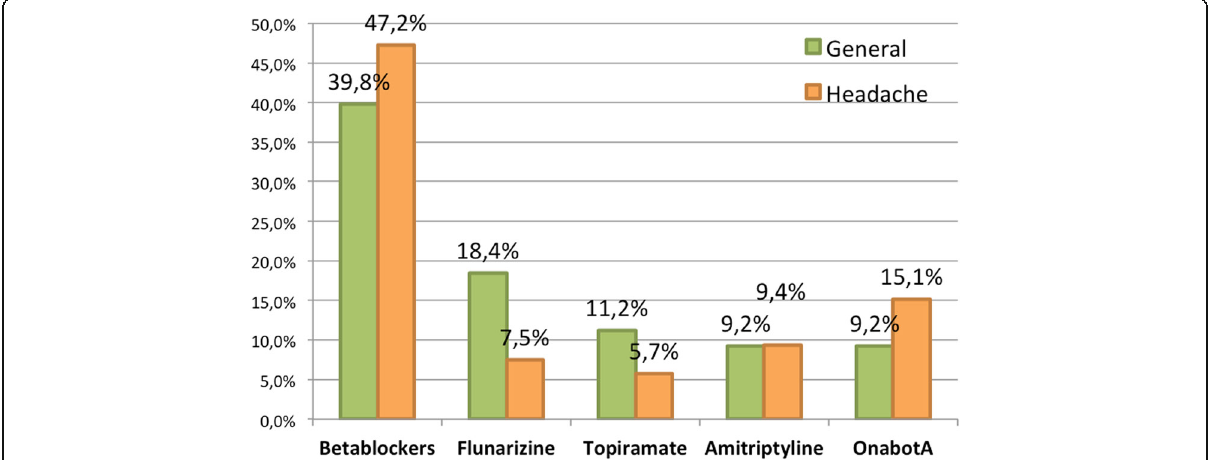
Fig. 3 Opinions among surveyed neurologists about each drug tolerability. In orange: answers from Neurologists with special interest in headache. In green: answers from general neurologists